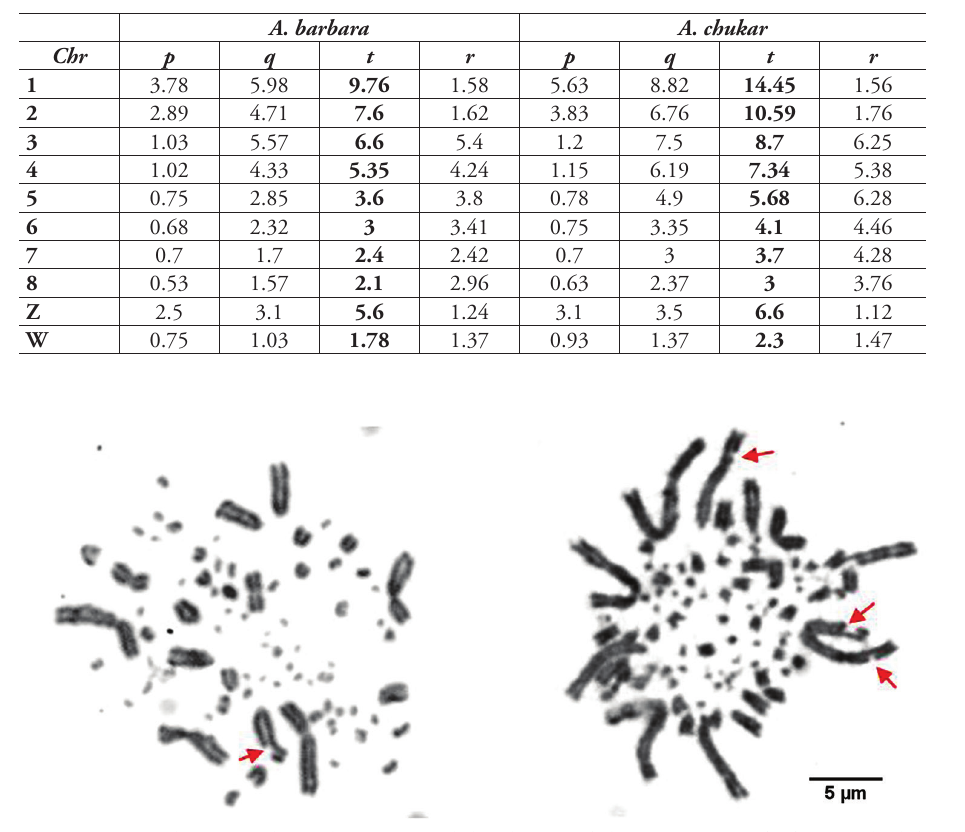
bands (Fig. 4, Table 2) Chromosome 1 P arm Barbary partridge: two regions. 11 G bands with a visible negative band (21) which di- vides the p arm into two regions. A large terminal positive band is also visible (26).